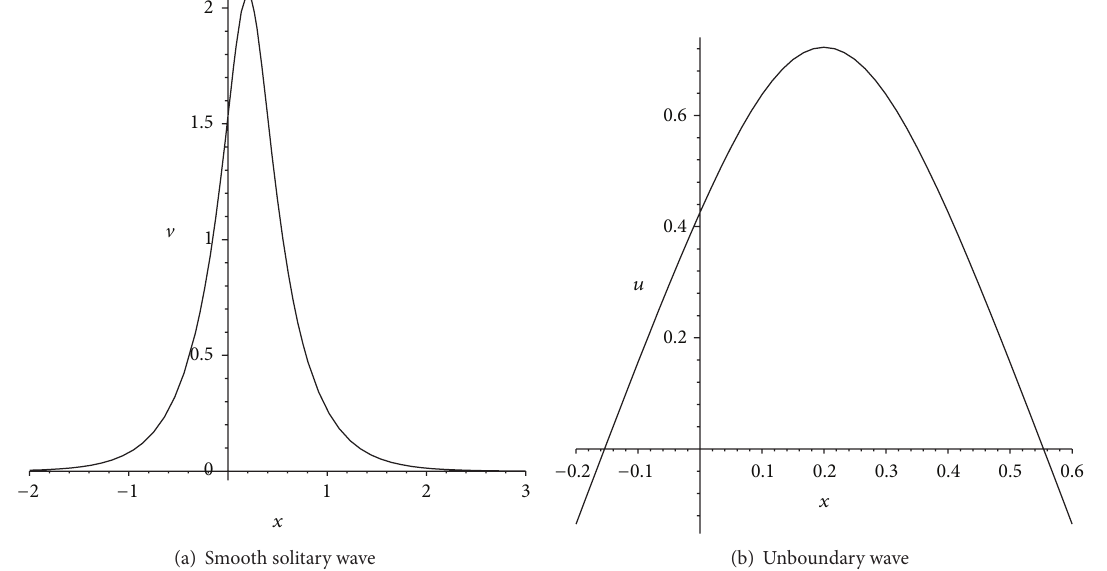
Figure 1: The phase portraits of solutions (21) and (22) for 𝑚 = 4 , 𝛼 = 3 , 𝛽 = −1 , 𝑐 = 2 , ℎ = 9 , 𝑡 = 0.1 .